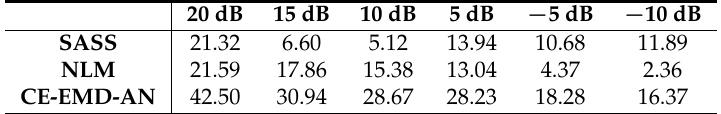
Table 2. Percentage SNR imp improvement relative to the three referenced algorithms.